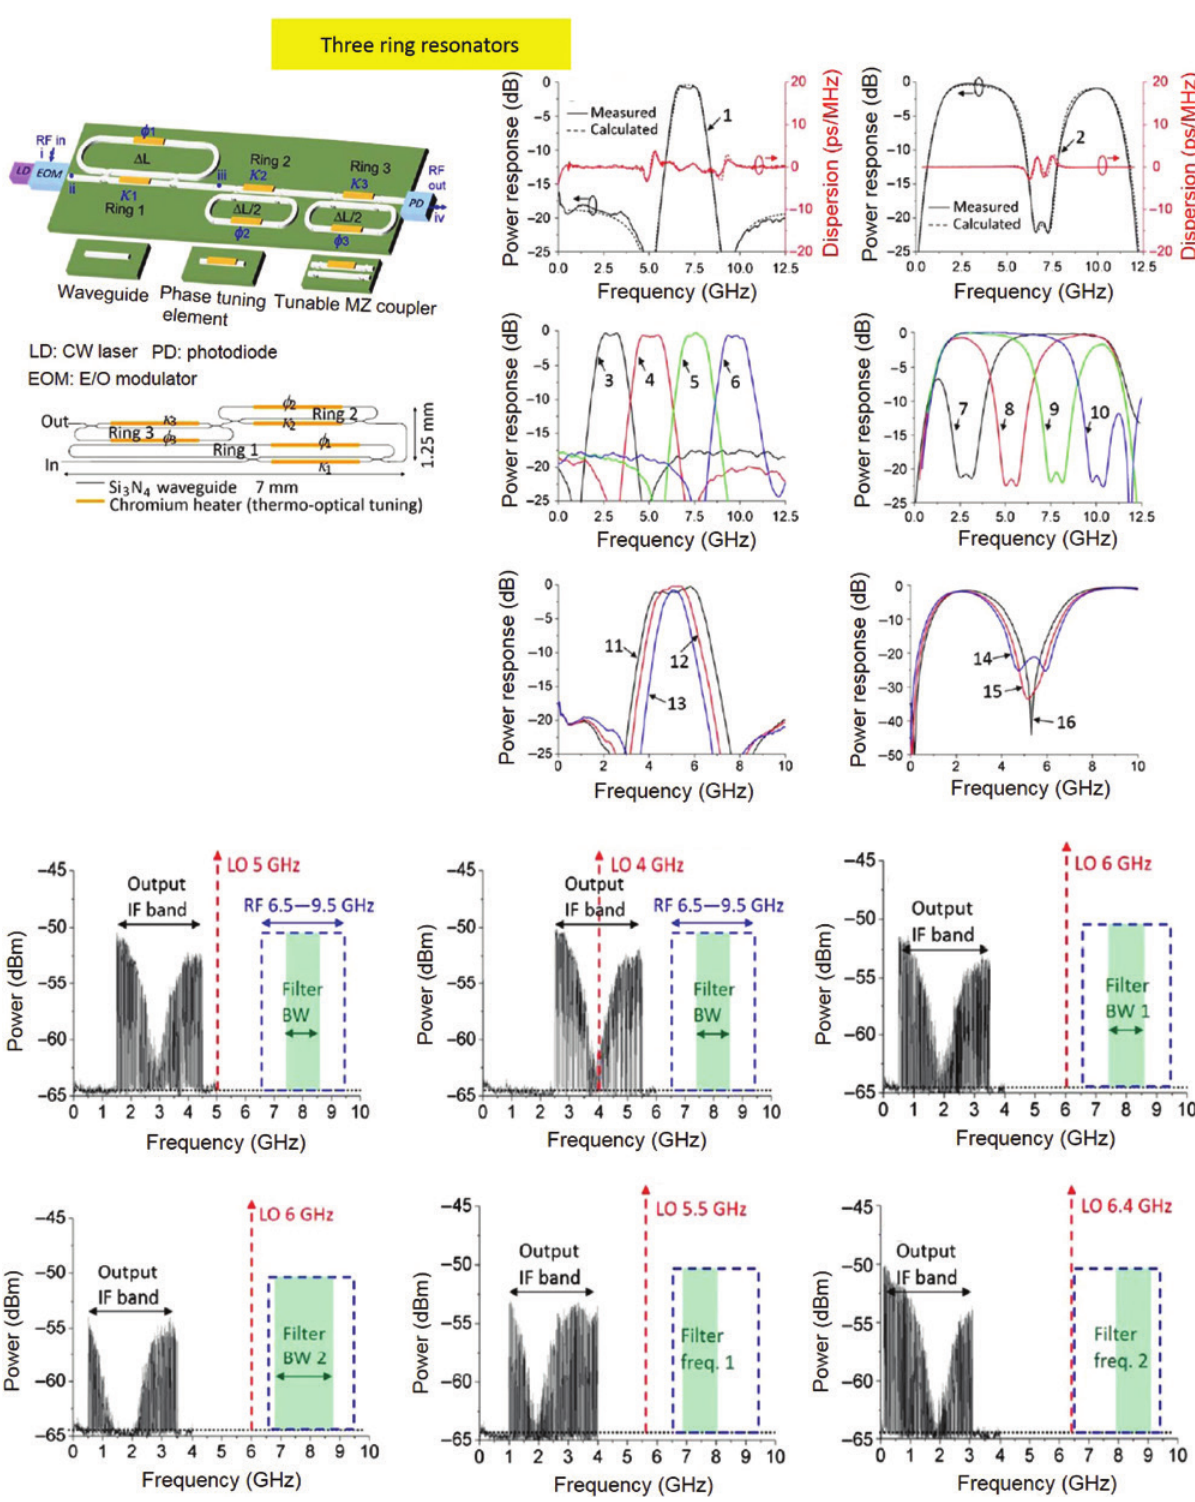
Figure 8: Microwave photonics implementations of RF filters using optical signal processor chips that comprise three ring resonators, showing the evolution toward DSP flexibility and incorporation of frequency down-conversion [63] (Copyright in 2016, Optical Society of